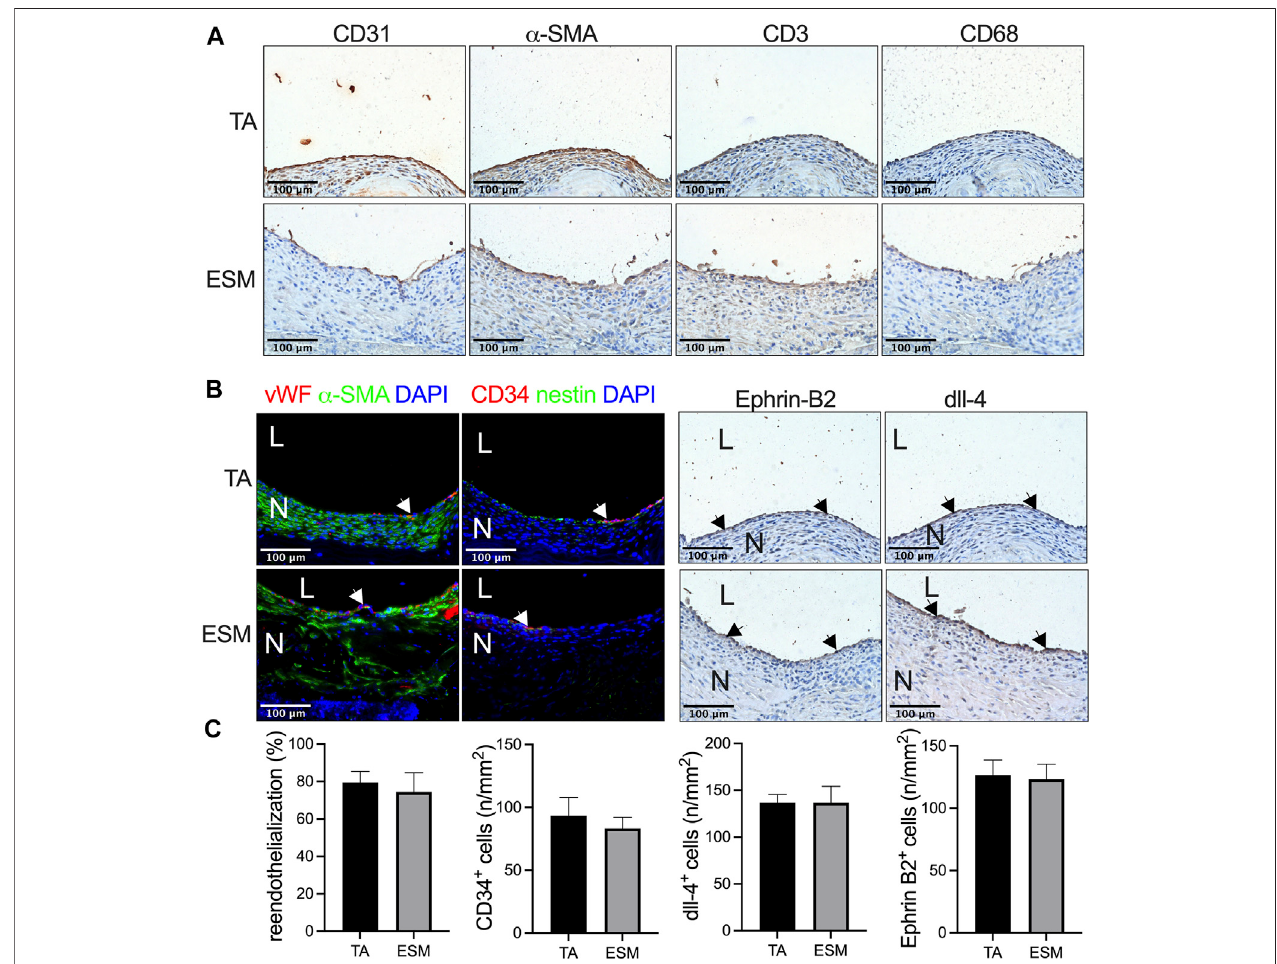
FIGURE 3 | Neointimal cell composition after ESM patch angioplasty at day 14. (A) Photographs of immunohistochemistry stained for CD31, α -actin, CD3, and CD68 in the neointima in the TA and SEM patches; scale bar, 100 μ m; n = 3. (B) Photographs of the immuno fl uorescence staining for von Willebrand factor (red), α - actin(green), and DAPI (blue); CD34 (red), nestin (green), and DAPI (blue); photograph of immunohistochemical staining for Ephrin-B2 and dll-4 of the neointima; scale bar, 100 μ m; L, lumen; N, neointima; white or black arrows show the positive cell, n = 3. (C) Bar graphs showing re-endothelialization ( p = 0.6985, t -test), CD34- positive cell numbers ( p = 0.5879, t -test), dll-4-positive cell numbers ( p = 0.8541, t -test), and Ephrin-B2-positive cell numbers ( p > 0.9999, t -test) in the TA and ESM patch groups at day 14, n =